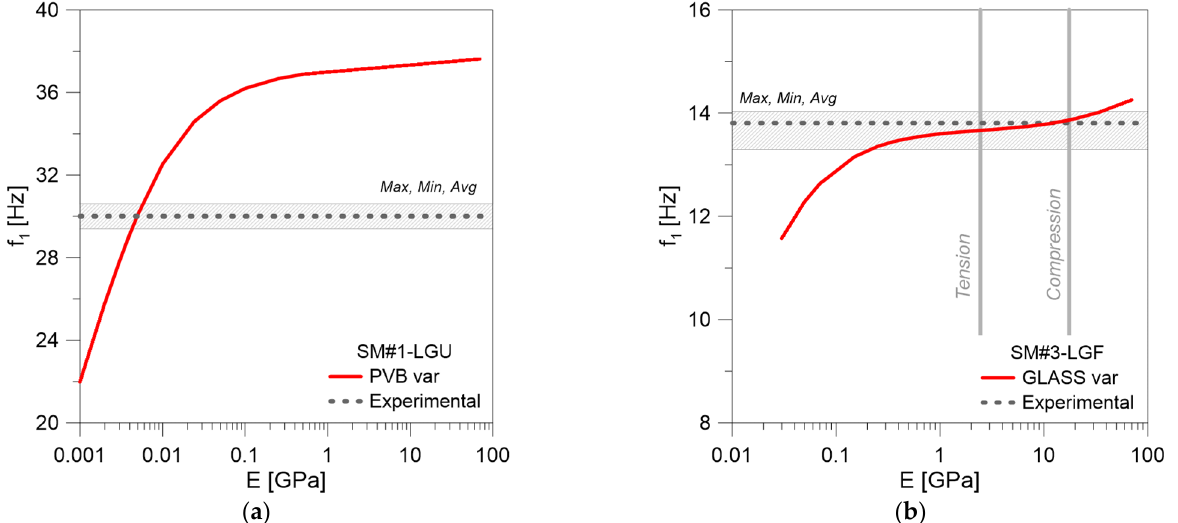
Figure 14. Material characterization based on FE model updating: ( a ) derivation of equivalent interlayer stiffness for SM#1–LGU system; and ( b ) equivalent modulus for fractured glass layer (SM#3–LGF system).